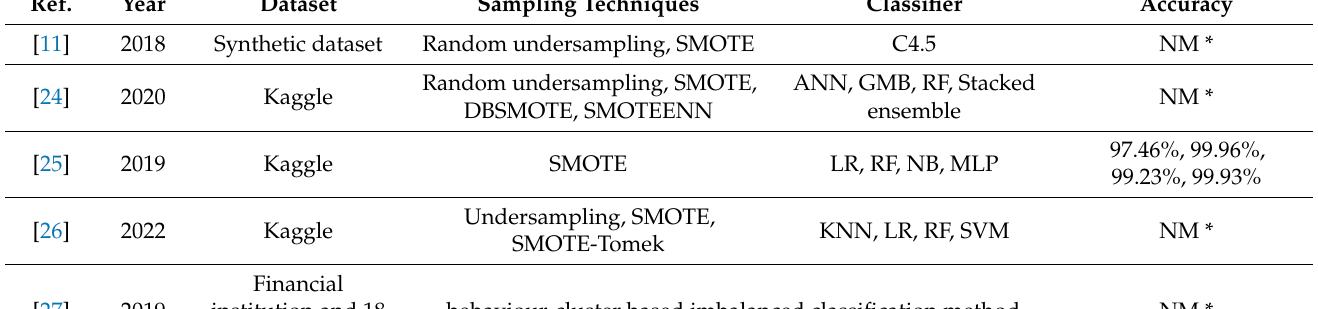
Table 1. Comparison of sampling techniques for fraud detection in credit card transaction datasets.